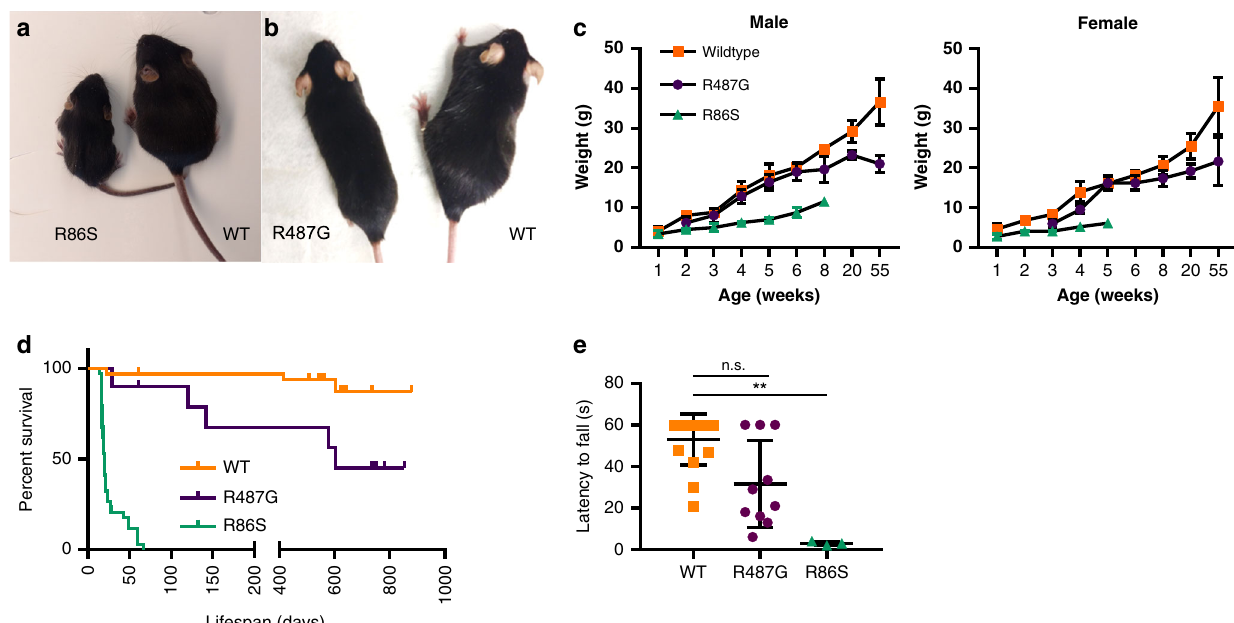
Fig. 1 Mutations in mouse Nemf lead to de fi cits in body weight, motor function, and lifespan. a , b A 18-day-old R86S homozygous mutant (R86S; a ) and 55-week-old R487G homozygous mutant (R487G; b ) mice are smaller compared to wild-type (WT) littermates. c Body weight curves of male and female wild-type (orange squares), R487G (purple circles), and R86S mice (green triangles). Mean ± SD are indicated for each timepoint. Source data are